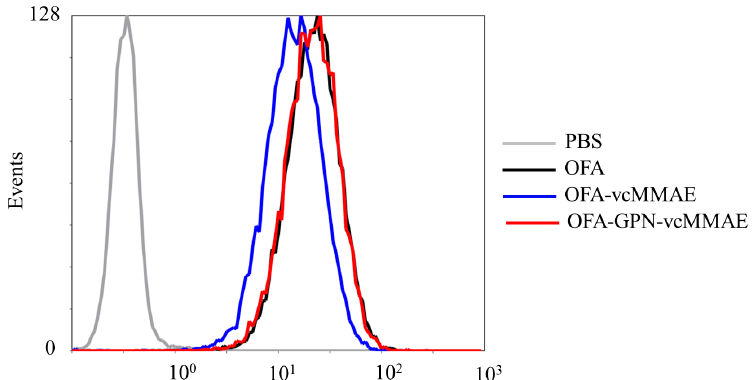
Figure 6. Determining the binding of antibody and ADCs to CD20-positive Daudi cells by flow cytometry. PBS: phosphate-buffered saline; OFA-vcMMAE: the direct enzymatic ADC.